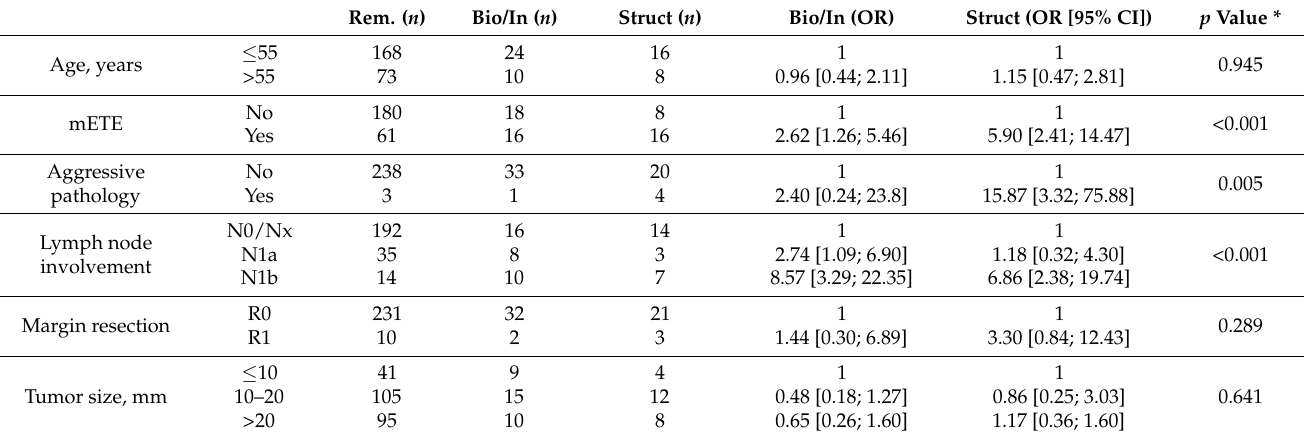
Table 3. Univariate analysis of factors associated with clinical outcome at 5 years. Rem. ( n )